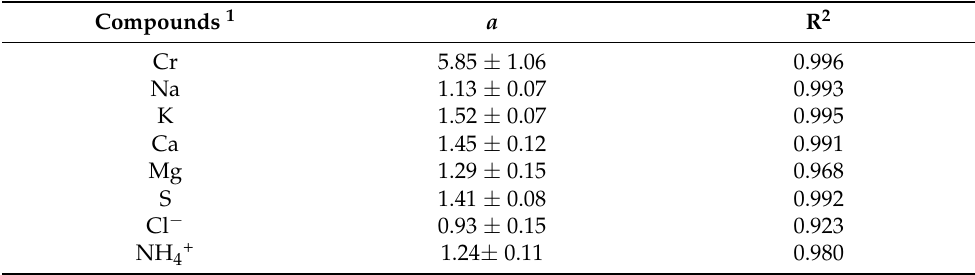
Table 4. Fitting parameters to the exponential decay of the different compounds in diafiltration retentate: a is the exponential term, whereas the fitting quality is expressed by the respective R 2